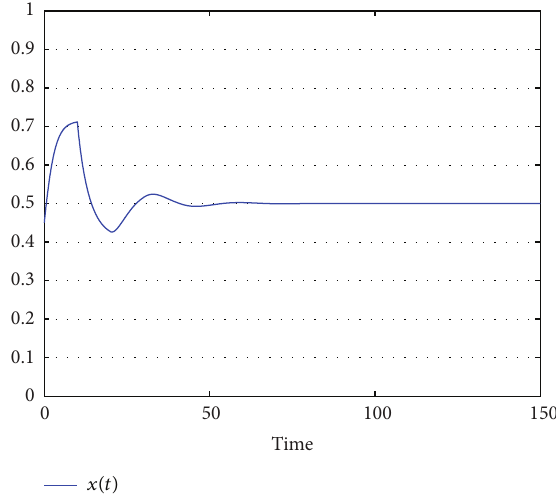
Figure 1: Model (33) becomes a deterministic model.